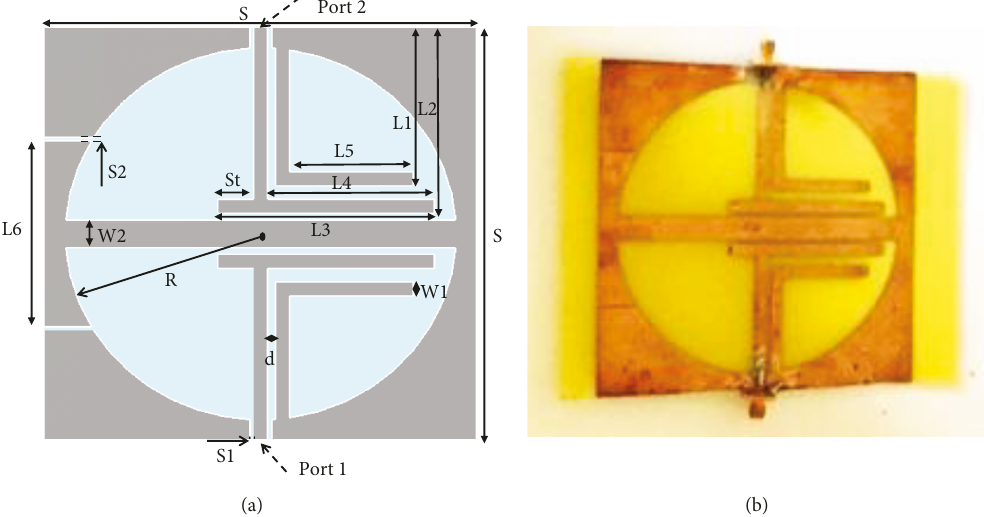
Figure 1: (a) Geometry of the proposed antenna; (b) photograph of the fabricated antenna.